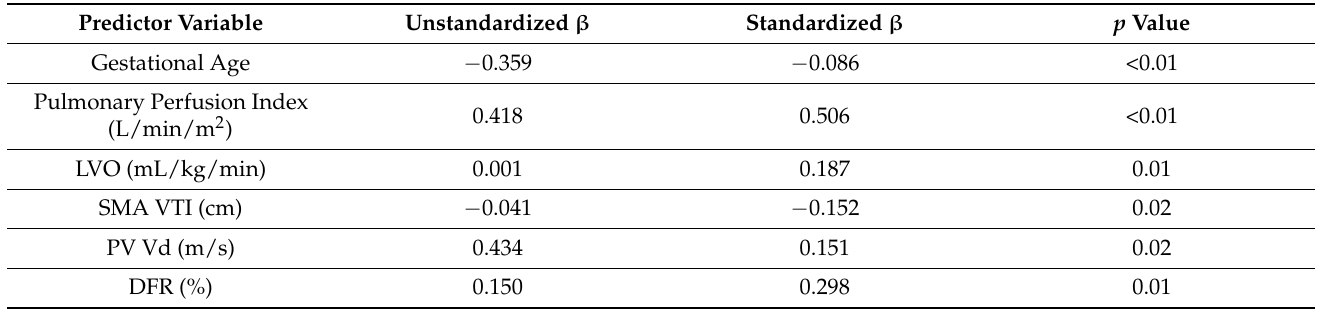
Table 3. Regression model used to derive PDAss.